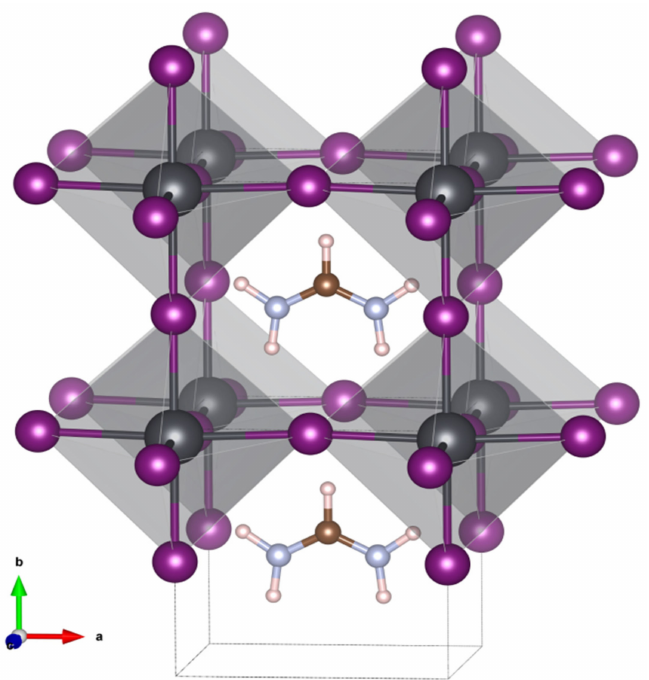
Figure 4. Model of the cubic crystal structure for the black formamidinium lead iodide, α -[HC(NH 2 ) 2 ] PbI 3 , at 298 K